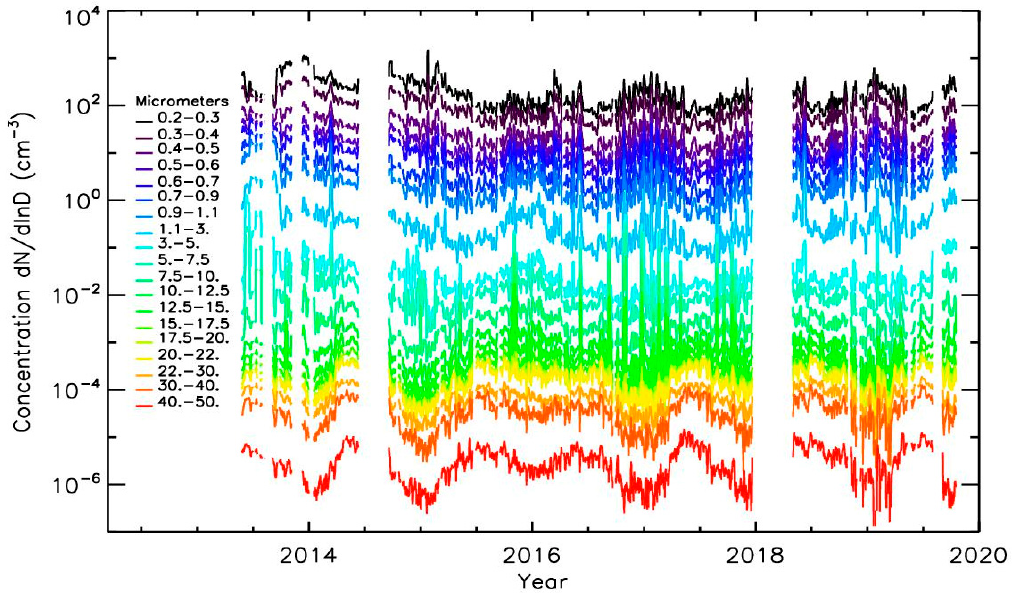
Figure 4. Temporal evolution of number concentrations for the 19 LOAC size classes when the balloon is at ground (the data have been smoothed by a sliding smoothing procedure with a width of 2 days).